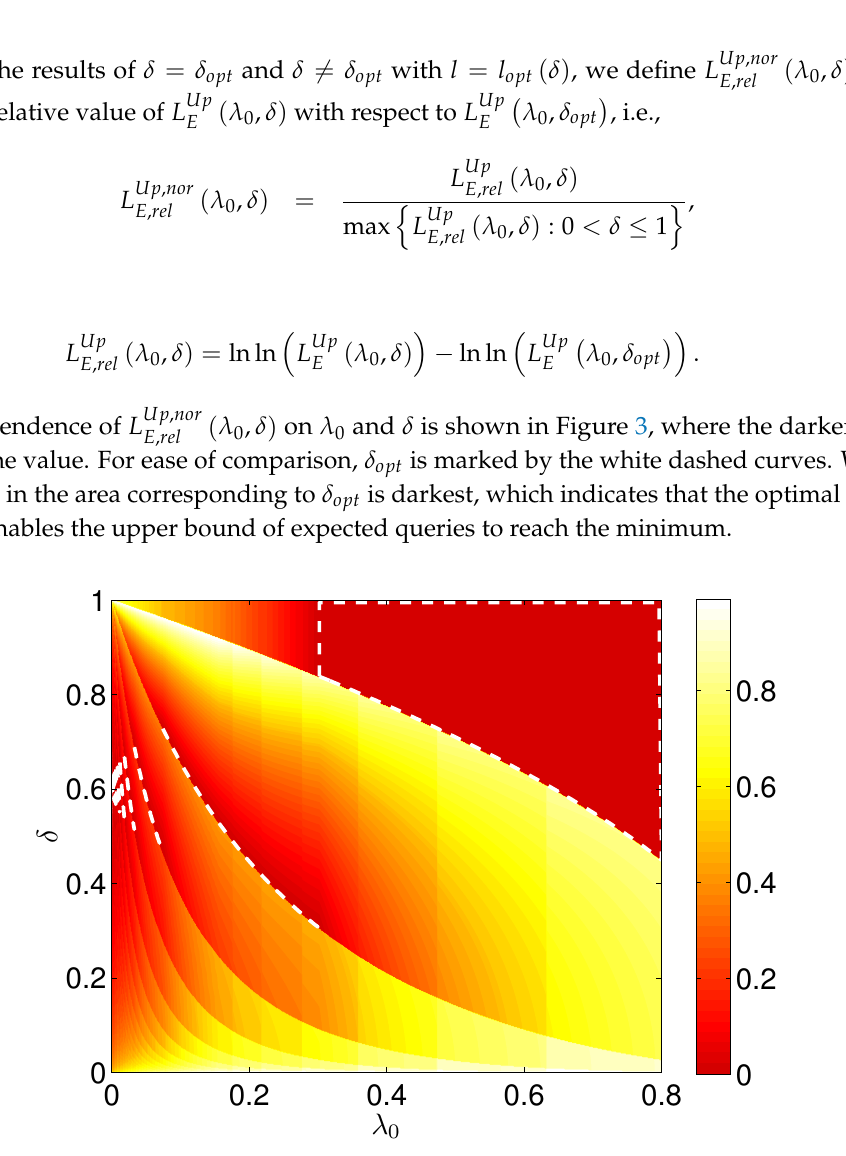
( λ ) as a function of δ and λ 0 , δ E , rel